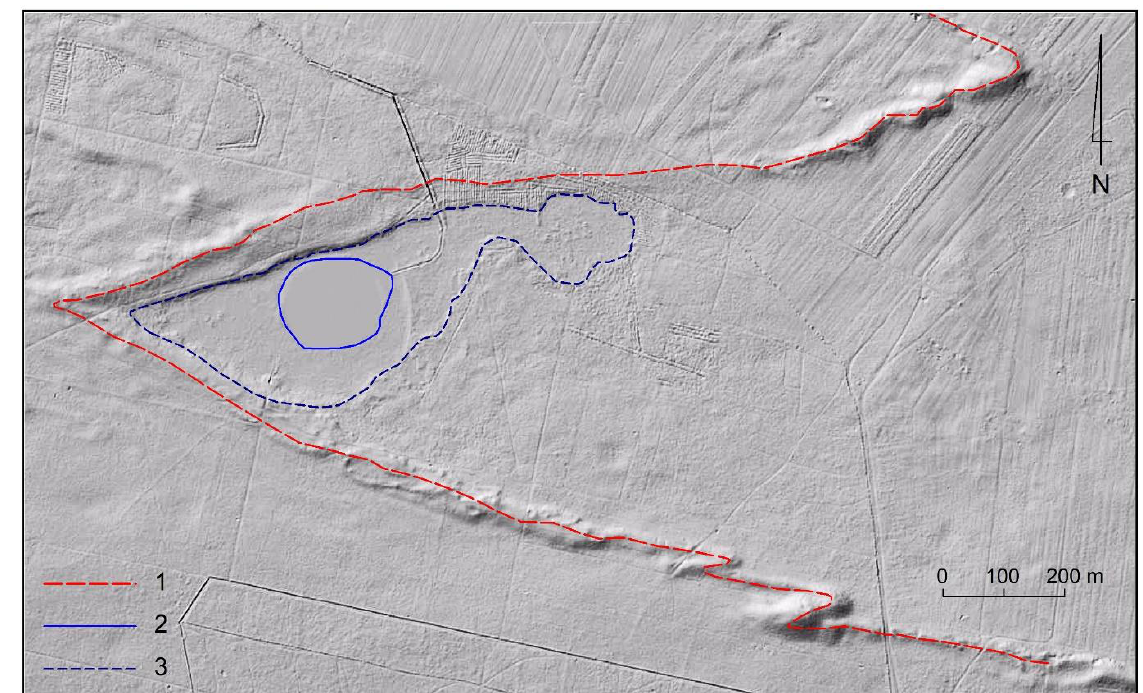
Figure 6. Geomorphological conditions of the location of the post-exploitation peat reservoir 9: 1: dune ridgeline, 2: reservoir shoreline at the lowest water level, and 3: reservoir shoreline at the highest water level (source: own study based on an image LIDAR obtained from geoportal.gov.pl (accessed on 27 December